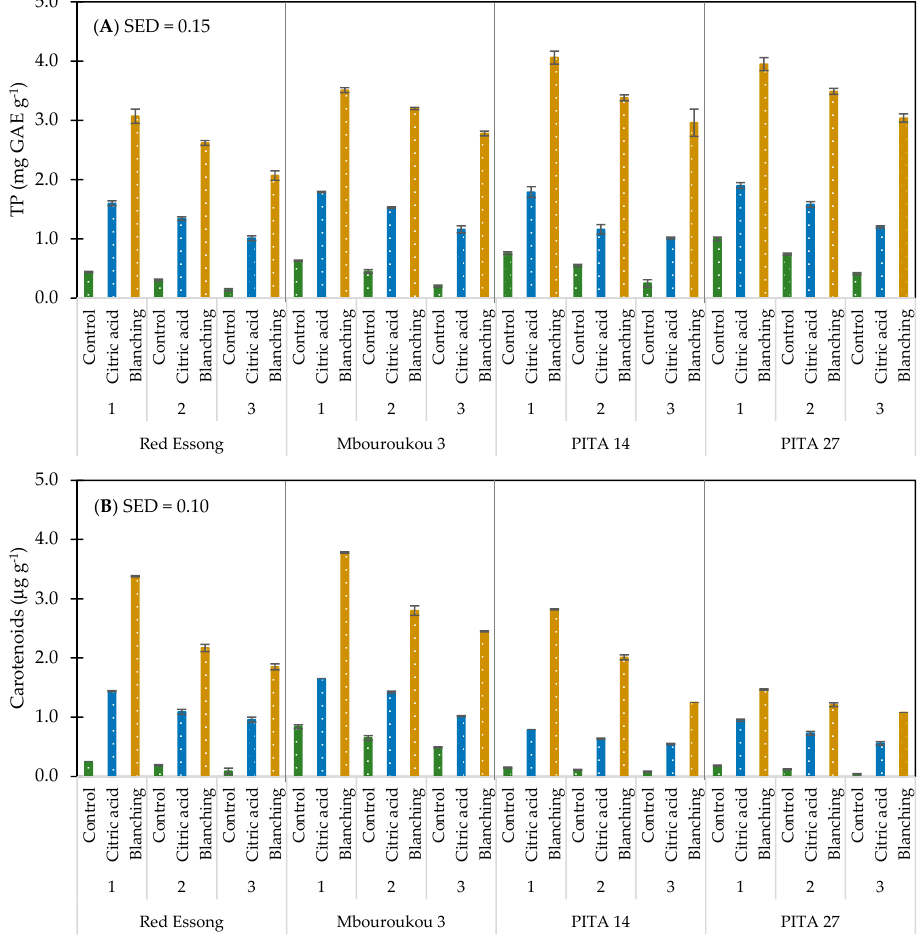
Figure 4. Total phenolic ( A ) and carotenoid contents ( B ) of plantain flours as influenced by cultivar, ripening stages, and pre-treatment methods. Ripening stage: 1 = mature green; 2 = green with a trace of yellow; and 3 = more green than yellow.